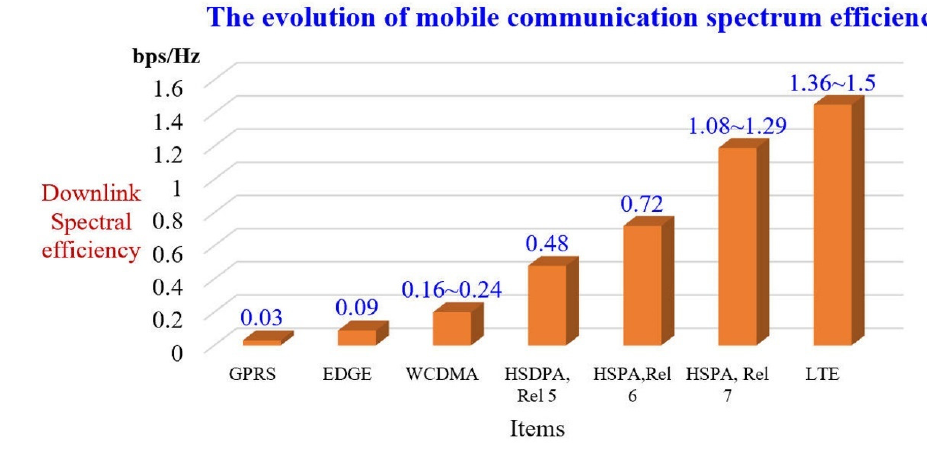
Figure 5. Evolution of mobile communication spectral efficiency.